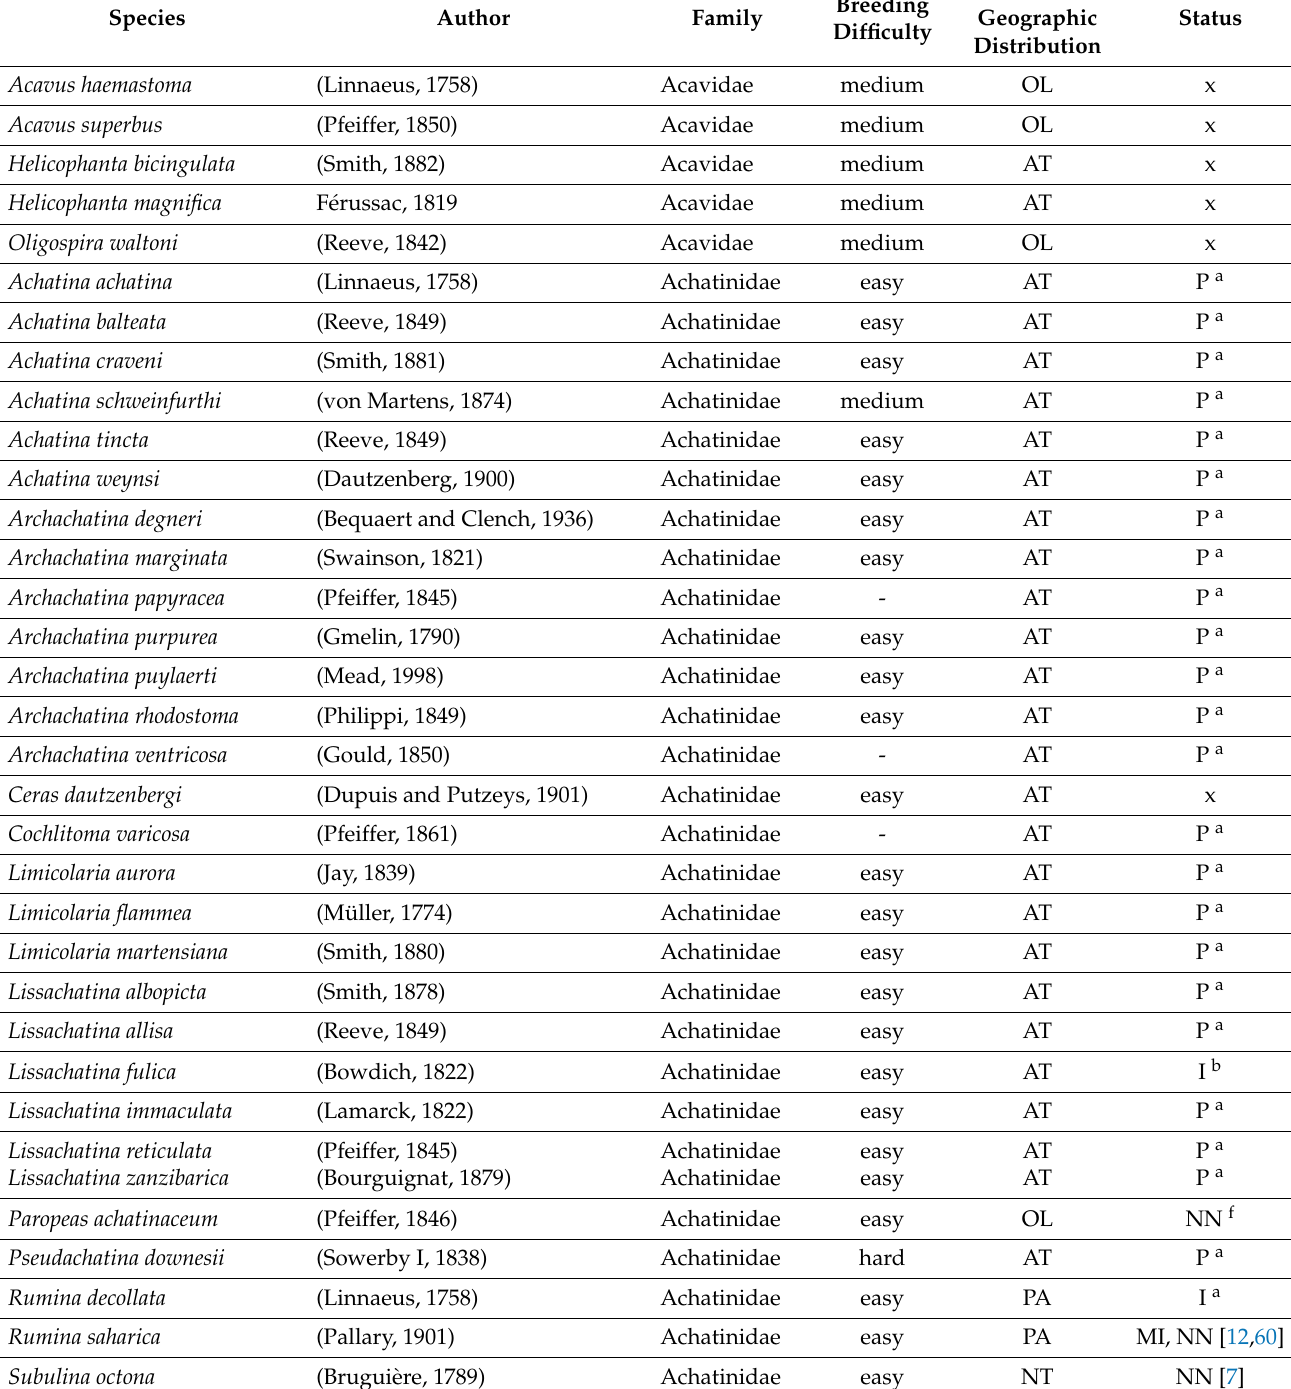
Table 1. The list of pet-traded terrestrial gastropods, species description, family, breeding difficulty (easy, medium, hard, following landsnails.org), native geographic distribution